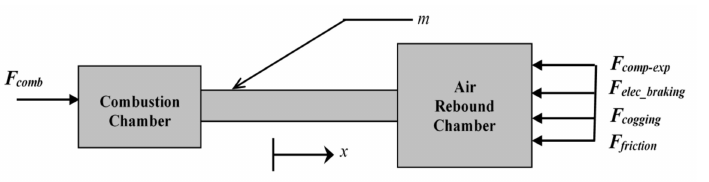
Figure 2. Velocity-based selector switch to achieve cyclic operation [5]. Copyright 2021